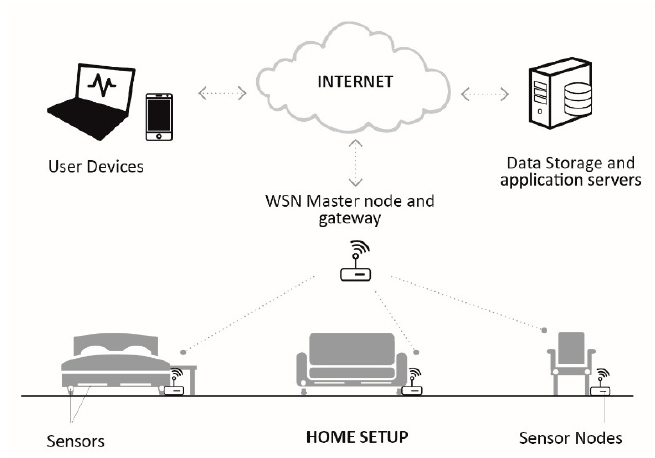
Figure 4. Intelligent furniture network connected to Internet based services. (Adapted from Heikkilä et al. [32]).